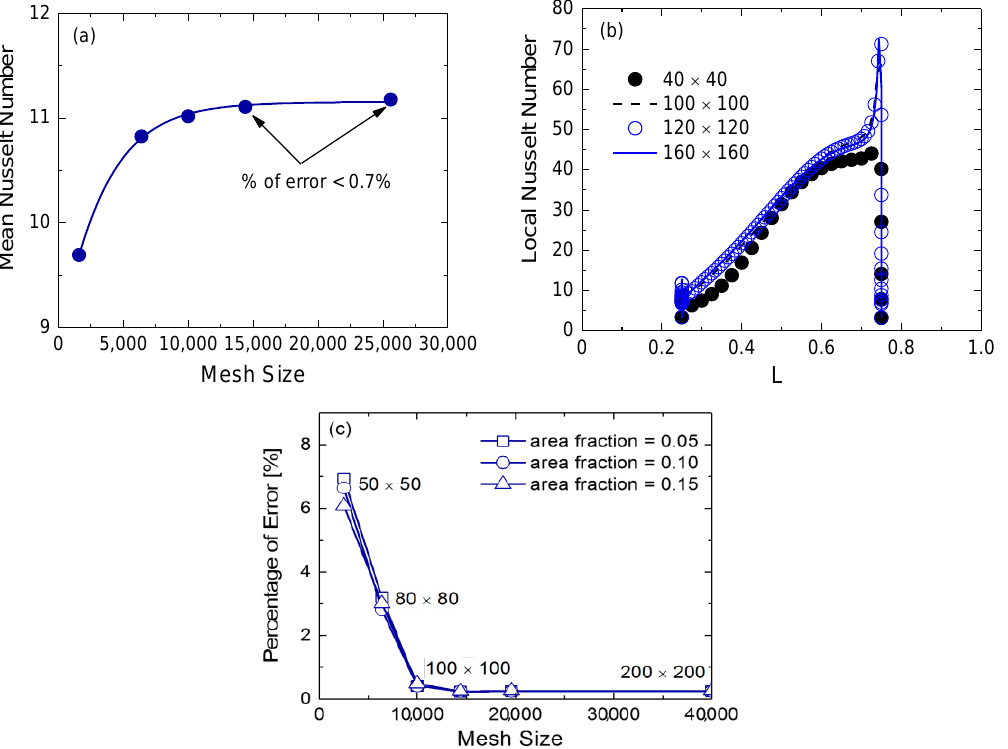
Figure 3. Convergence of numerical simulation for different mesh densities. ( a ) mean Nusselt number between hot and cold surfaces; ( b ) local Nusselt number over the fin surface; and ( c ) percentage of error for the average Nusselt number for three fin area fractions.